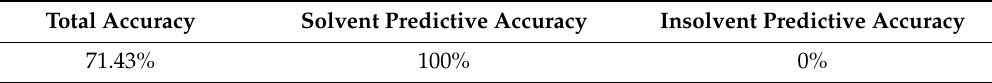
Table 4. Overall accuracy of SVMRK on the testing